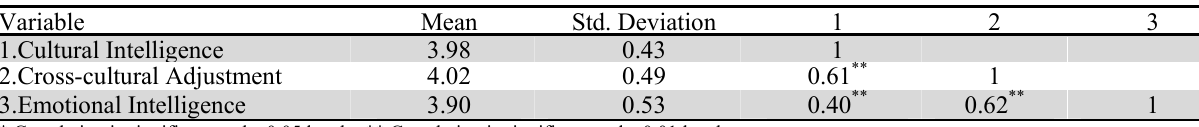
Main variables`s Pearson Correlation Variable Mean